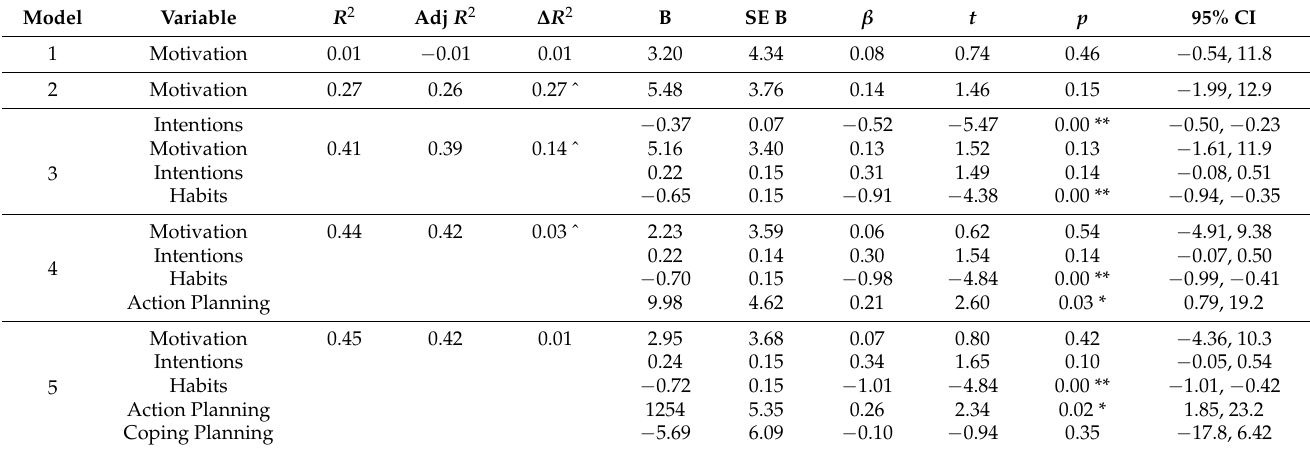
Table 3. Hierarchal multiple regression model for change in exercise time